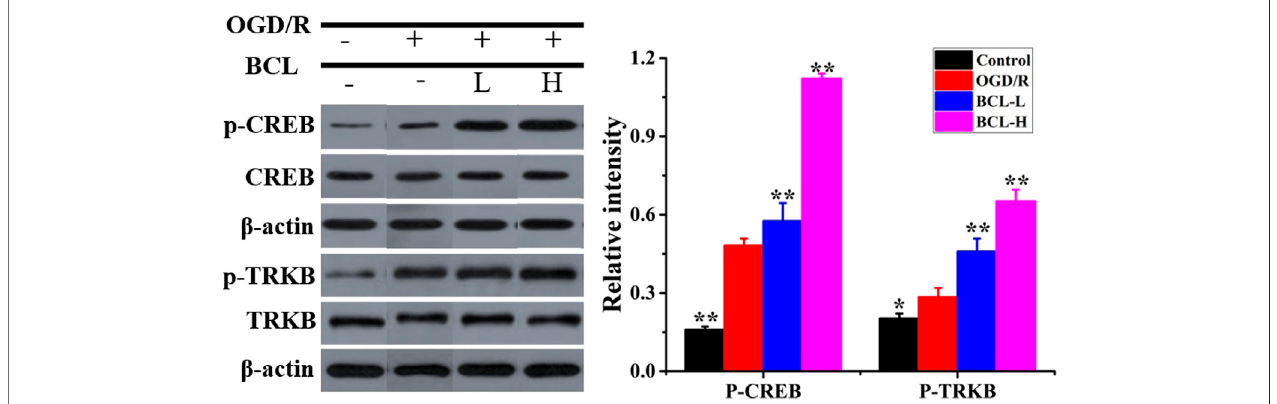
FIGURE 6 | Effects of BCL (34.38 μ g/ml, 8.59 μ g/ml) on the expression of CREB and TrkB in the NA system after OGD/R. Quanti fi ed results were normalized to β -actin expression. ** p < 0.01, * p < 0.01, vs. OGD/R group.